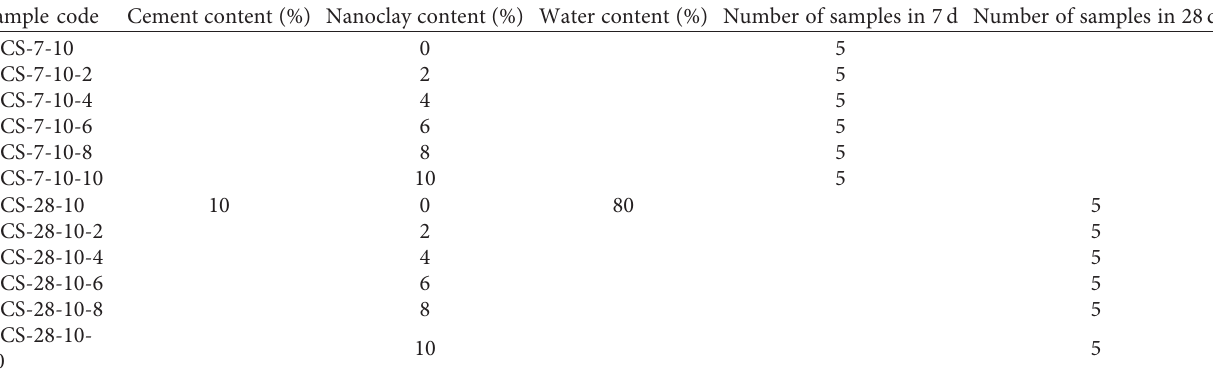
Table 5: Sample design scheme of coastal cement soil modified by nanoclay.